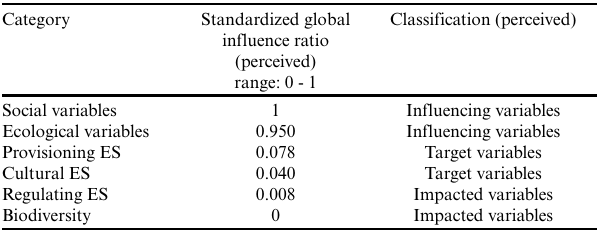
Table 3 . Classification of standardized global influence ratio as a synthetic outcome of the French Alps consultative process (number of influences emitted by a category divided by the number of influences received by the same category; standardization by subtracting the minimum value to each ratio and dividing by the range of values). ES = ecosystem